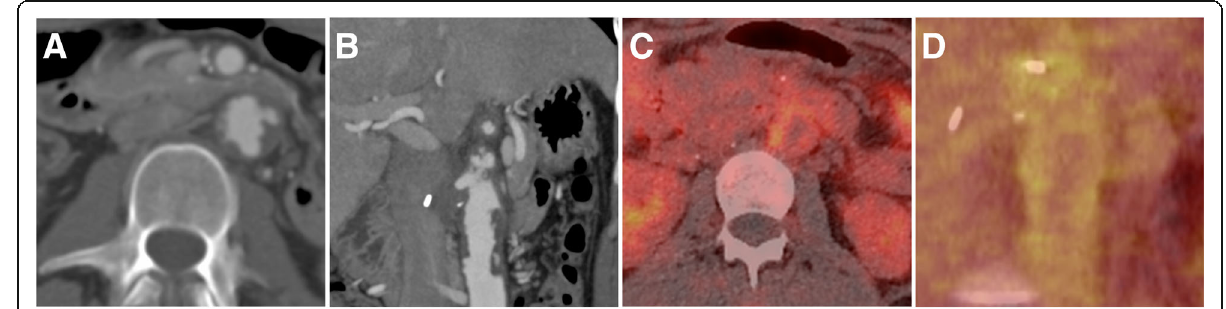
Fig. 8 Angiosarcoma of the abdominal aorta in a 22-year-old woman. Computed tomography angiography (CTA) depicts tumorous mass extending within the aortic lumen resembling thrombus or atheroma ( a , b ). The intraluminal mass however showed increased metabolic activity on 18 F- FDG-PET/CT ( c , d ), indicative of a malignant